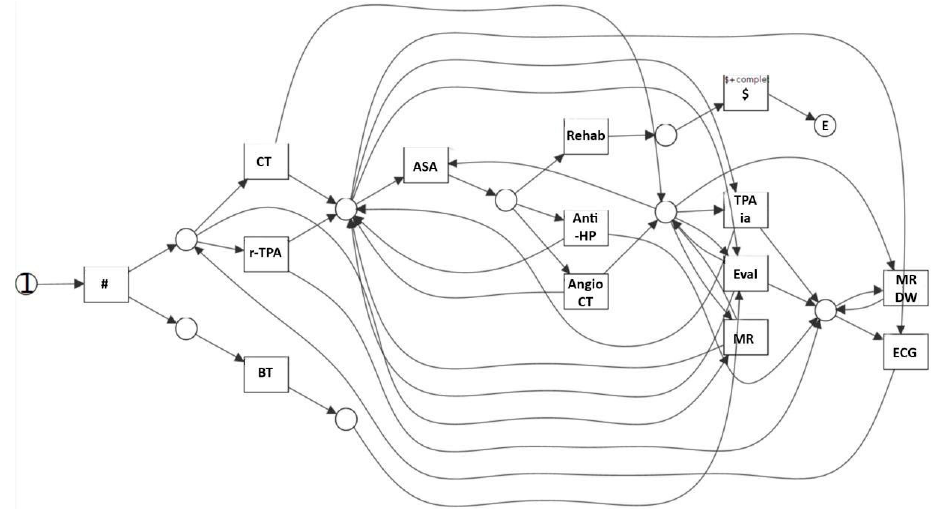
Figure A4. Process model generated by the ILP plugin. The place indicated as “1” represents the starting place, while the “E” represents the ending (final) state of the model.